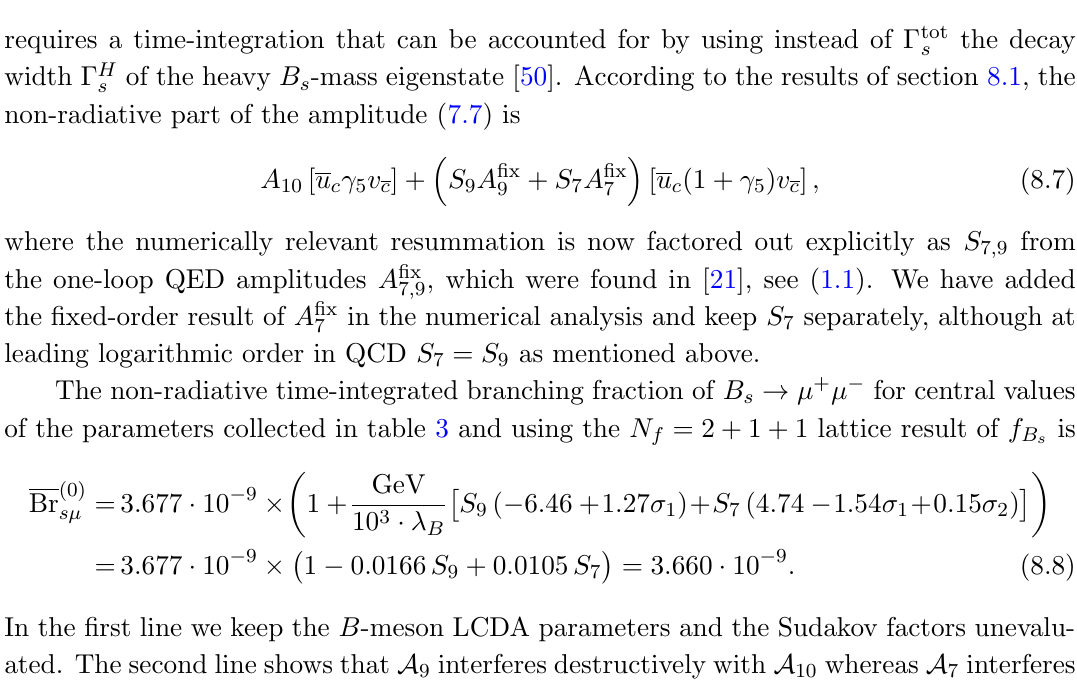
Table 3. Numerical input values for parameters: note that (cid:11) (5) em ( m Z ) has been determined with (cid:11) (5) s ( m Z ) = 0 : 1187(16) in [51] and the corresponding (cid:1) (cid:11) (5) em,hadr ( m Z ) = 0 : 02764(7). The B - meson decay constants are averages from the FLAG group for N f = 2 + 1 from [57{61] and for N f = 2 + 1 + 1 from [2, 62{64]. The B s;d lifetimes are prepared by HFLAV for the PDG 2018 review [51]. The same numerical values of (cid:21) B and (cid:27) 1 ; 2 at the reference scale (cid:22) 0 = 1 GeV are used for B s and B d mesons. The values of the Wilson coe(cid:14)cients at (cid:22) b = 5 : 0 GeV